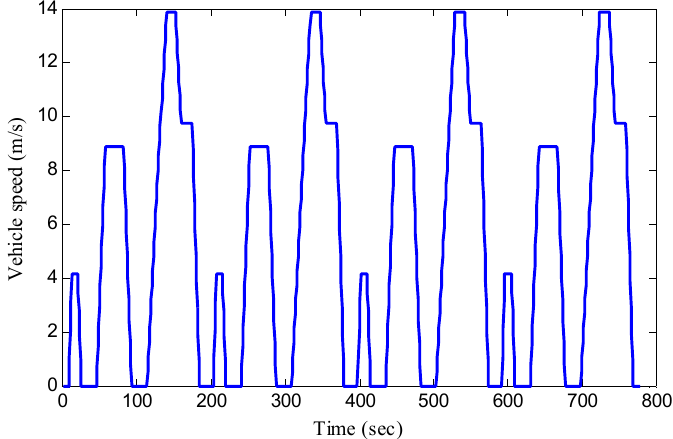
Figure 19. Economic commission for Europe (ECE) urban cycle manoeuvr in case study 3.